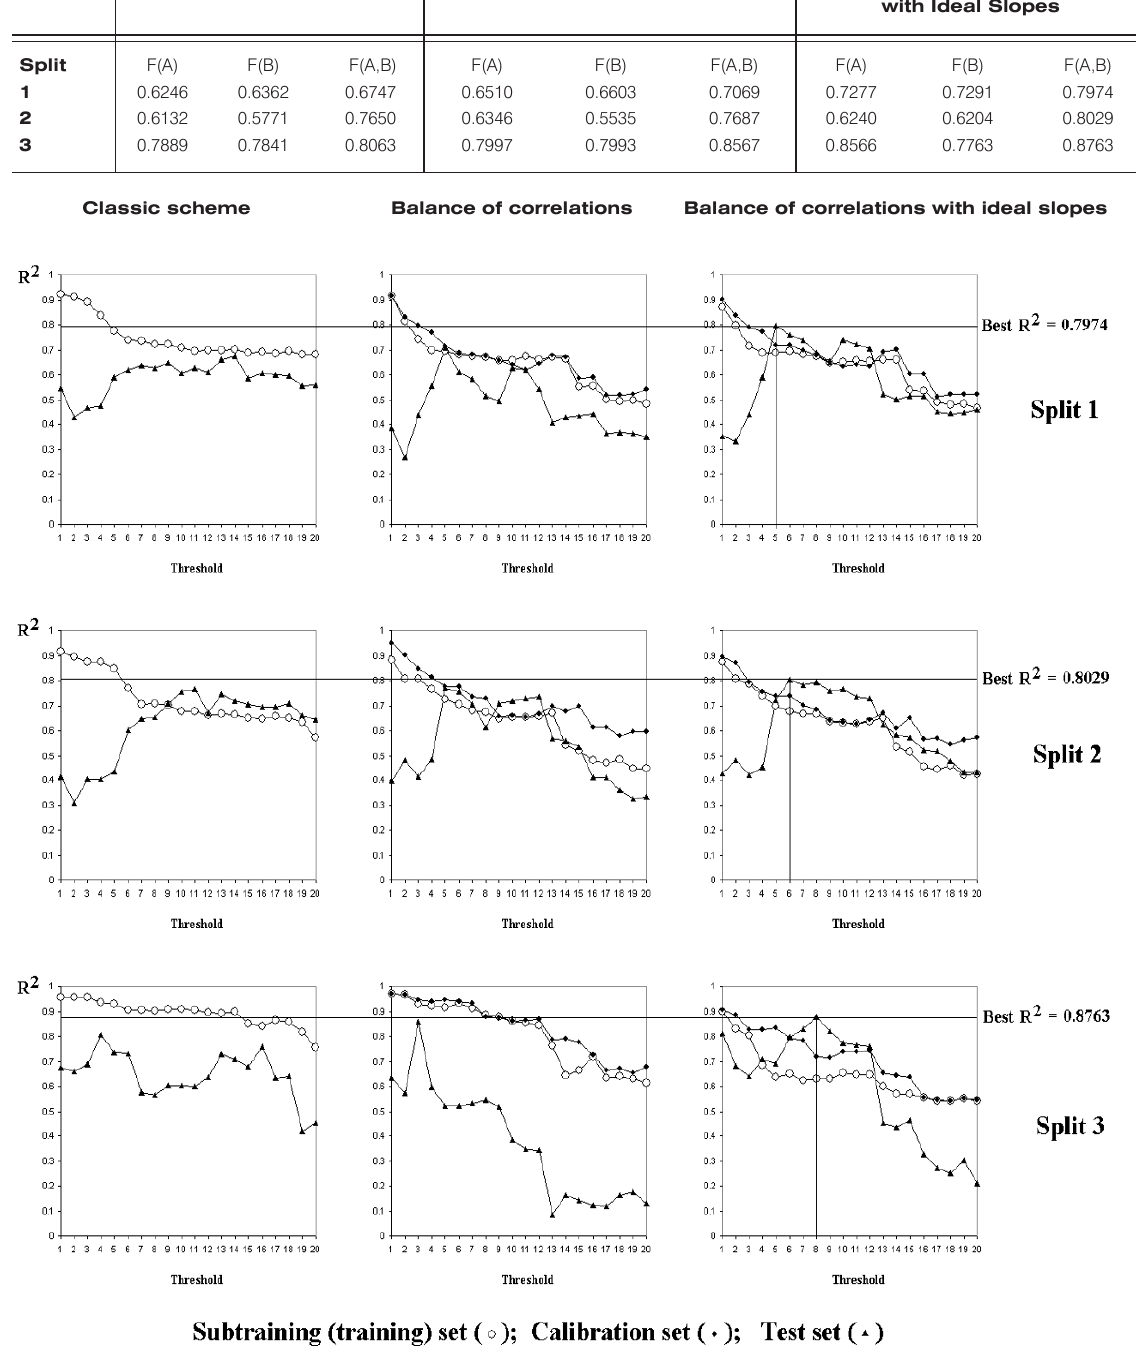
Figure 2. Diagrams of correlation coefficients versus the Threshold values for three random splits. One can see that the balance of correlations with ideal slopes gives the maximum correlation coefficient between DCW and pIC calculated with Eq.